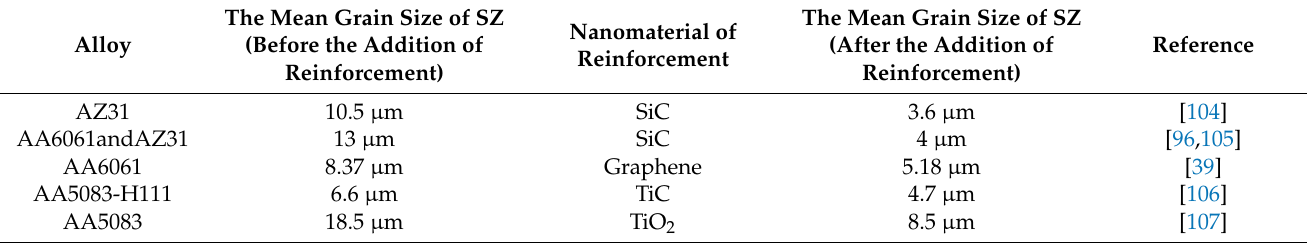
Table 2. Grain size evolution during FSW through addition of reinforcements.